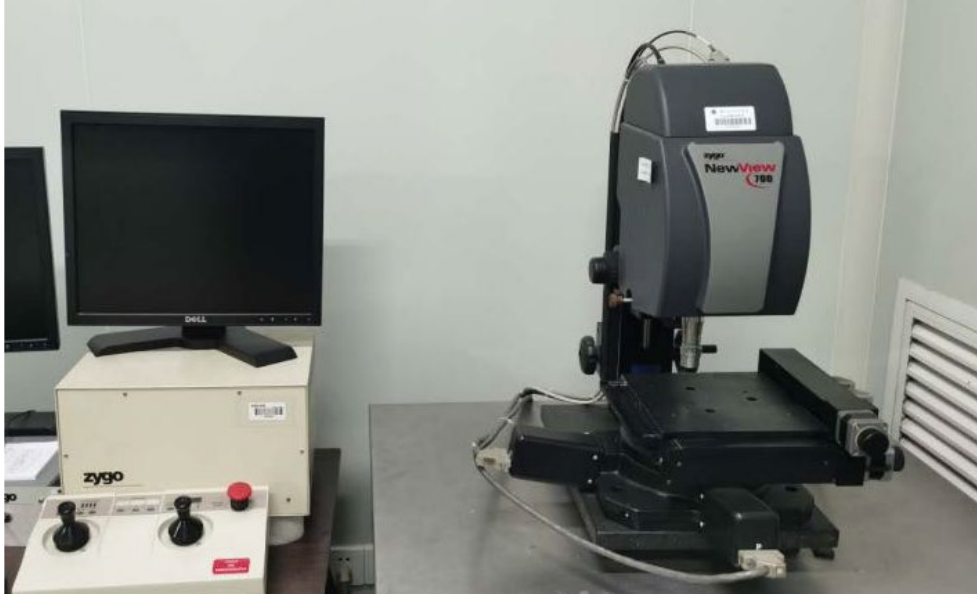
Figure 1. White light interferometer.